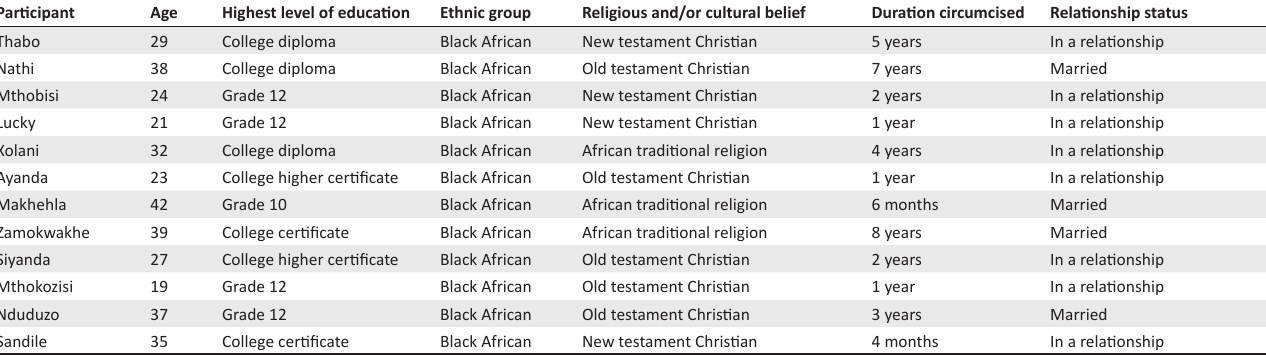
TABLE 1: Profile of participants. Participant